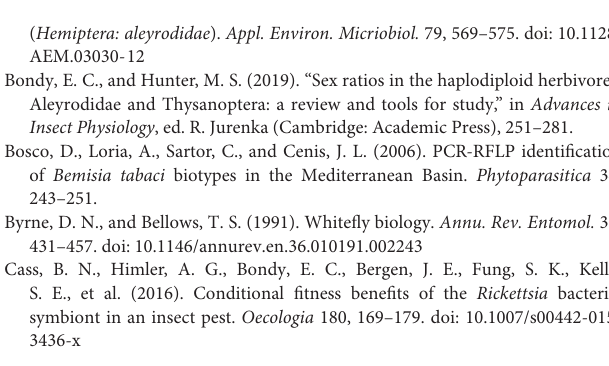
Supplementary Figure 1 | Phylogenetic position of Hamiltonella of different insect hosts based on the 16S rRNA sequences ( ∼ 720 bp). Maximum likelihood algorithms available in MEGA-X were used to infer phylogenetic relationships of the sequences that are shown as a cladogram. Hamiltonella sequences of 16 MED populations from this study are indicated in red. The Genbank accession number is shown in bracket. Bootstrap values ( > 50%) are shown on branches. Supplementary Figure 2 | Phylogenetic position of Cardinium of different whitefly populations based on the 16S rRNA sequences ( ∼ 390 bp). Maximum likelihood algorithms available in MEGA-X were used to infer phylogenetic relationships of the sequences that are shown as a cladogram. Cardinium sequences of 12 MED populations from this study are indicated in red. The Genbank accession number is shown in bracket. Bootstrap values ( > 50%) are shown on branches. Supplementary Figure 3 | Vertical transmission of Cardinium . (A) PCR detection of Cardinium in the progenies of four treatments of mating. (B) The transmission rates of Cardinium in the progenies of the four treatments of mating. The numbers above the columns indicate the positive total number of tested samples. Supplementary Figure 4 | Vertical transmission of Hamiltonella . Relative density of Hamiltonella (A) and Portiera (B) in F2 progeny produced by F1 adults in the four treatments of mating between CK (control) and AT (Antibiotics treatments). The data are mean ± SEM, and the different letters indicate significant differences at P < 0.05 (One-way ANOVA followed by LSD test for multiple